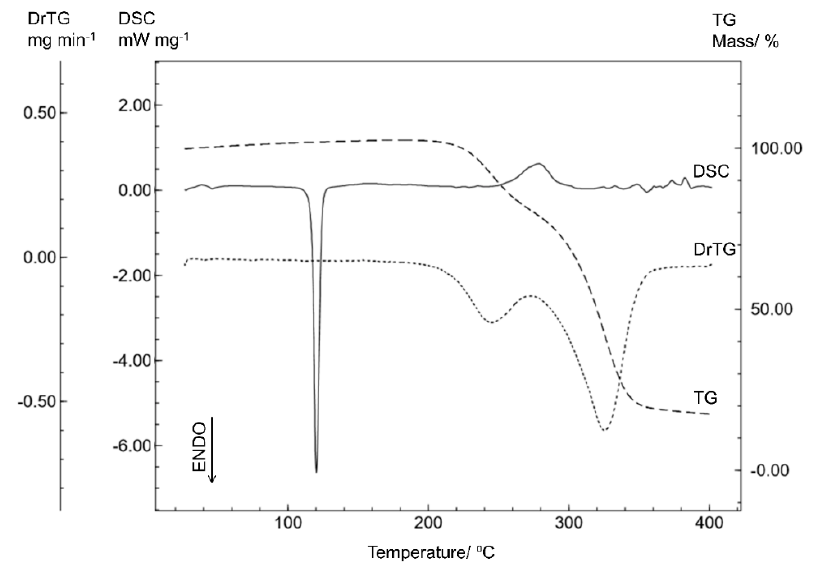
Figure 4. The DSC and TG / DTG curves of sitagliptin base form obtained with a synthetic air atmosphere (50 mL min − 1 ) and a heating rate of 10 °C min − 1 .